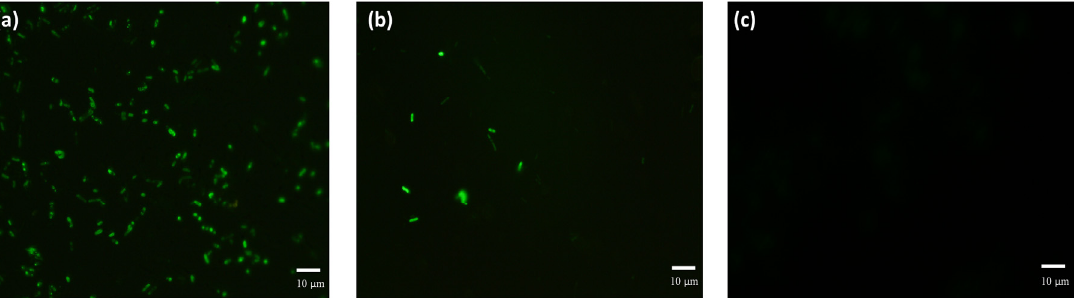
Figure 7. Fluorescence microscopy images of the Escherichia coli BL21 cells harboring pRSFduet_GFP and pASK_IBA2_YadA plasmids: ( a ) the untreated PET sample, ( b ) the NaAc-treated PET sample and ( c ) the KAc-treated PET sample.